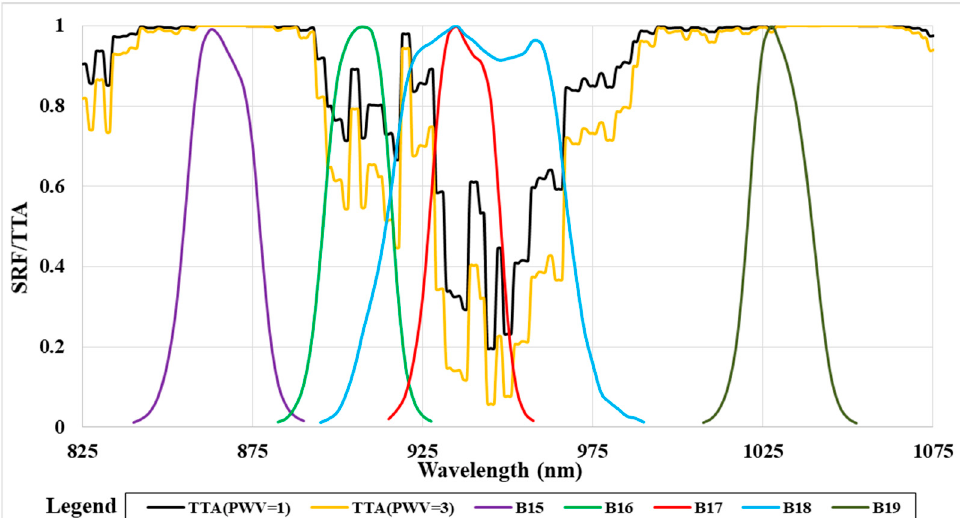
Figure 1. The spectral response functions of five NIR bands of MERSI-2 used for water vapor retrieval. The first line in the legend (black line) represents the total transmittance of the atmosphere (TTA) when the satellite view zenith angle and solar zenith angle are equal to 0 and PWV is equal to 1 g/cm 2 . The second line (yellow line) represents the TTA when the satellite view zenith angle and solar zenith angle are equal to 0 and PWV is equal to 3 g/cm 2 . The next five are spectral response functions of the five MERSI-2 bands used for water vapor retrieval. Table 1. Characteristics of five NIR bands of MERSI-2 used for PWV retrieval. Band